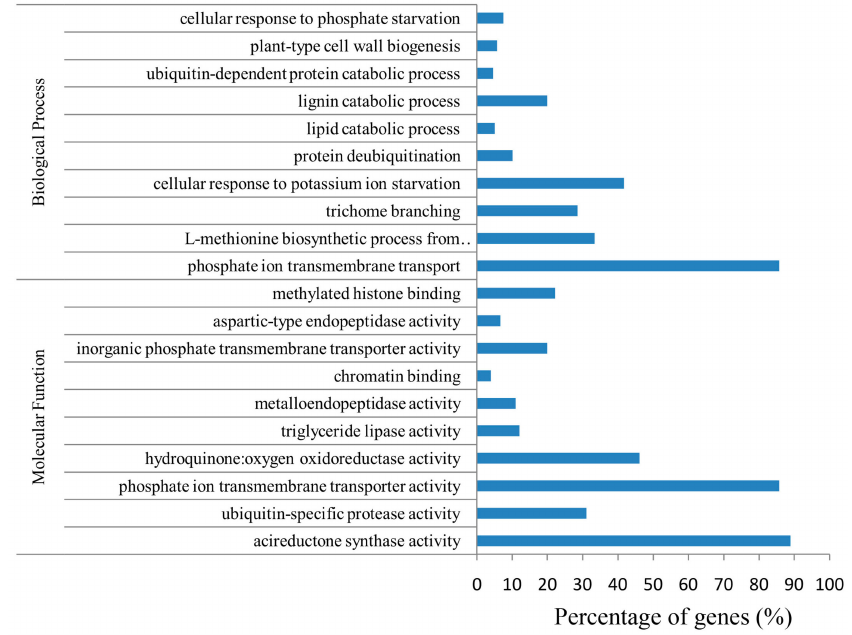
Figure 5. Gene Ontology (GO) term enrichments of the target genes of differentially expressed miRNAs (DEMs). The axis X represents the percentage of target genes to all genes in this category.